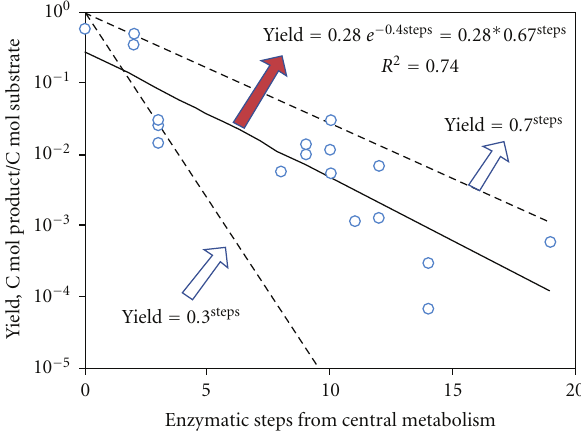
Figure 3: Product yields as a function of enzymatic steps from central metabolism. The solid line is the regression of published product yields by S. cerevisiae as a function of reaction steps from intermediate metabolites in central metabolism (including glycolysis, TCA cycle and pentose-phosphate pathways). The yield declines exponentially as the number of reaction steps increases. The dotted lines are boundary curves with yield e ffi ciencies of 30% and 70% respectively. All yield data from initial carbon sources are estimated from recent papers using our best judgment. The synthe- sized products and reaction steps are: